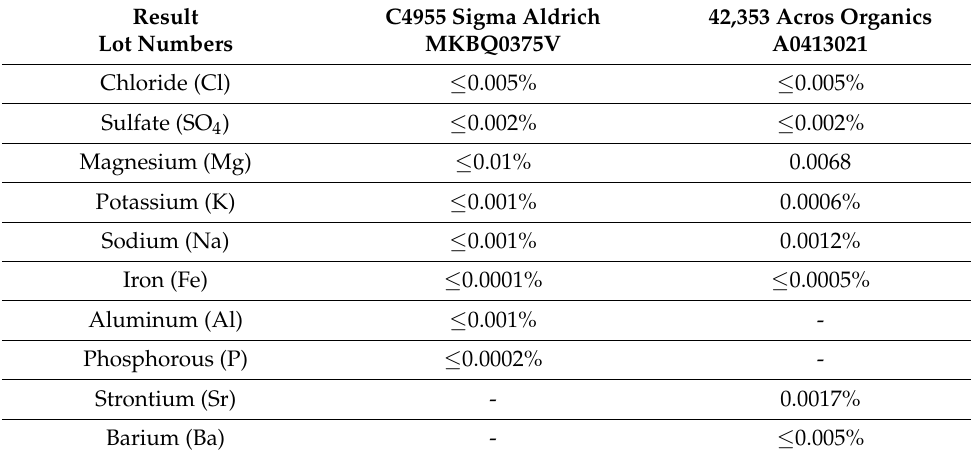
Table A1. Calcium nitrate salt reagent specifications 1